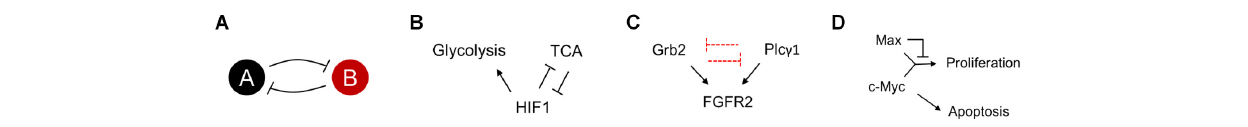
FIGURE 6 | (A) A double negative feedback loop is inherently bistable. The steady state of the system depends on the starting position of the network in the state space. (B–D) Regulatory topologies of metabolism (B) , signaling (C) , and gene regulation (D) , which could likely have distinct steady states. The different steady states reflect cellular commitment to proliferation or lack of (or apoptosis).